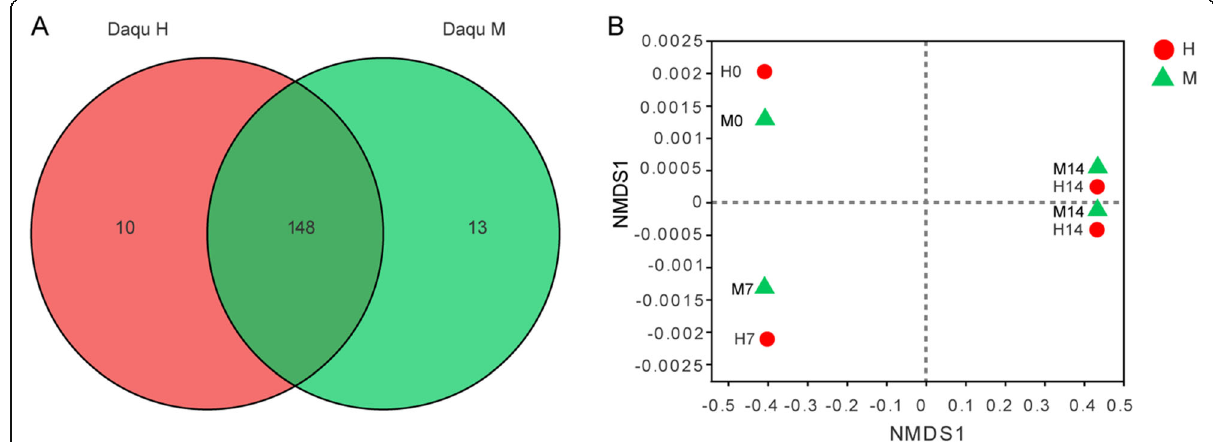
Fig. 4 Bacterial community comparisons and shared OTU analyses across Daqu H and Daqu M samples. a Venn diagram showing the unique and shared OTUs in different Daqu during the entire incubation process. b Non-metric multidimensional scaling (NMDS) plot generated using Bray distances at the genus level between samples of two types of